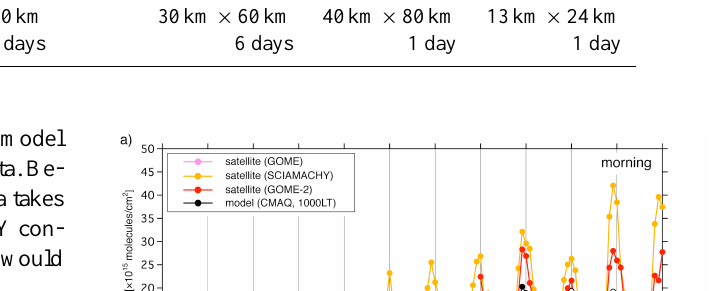
Table 1. Summary of satellite-based NO 2 measurement instruments. Instrument Satellite Period